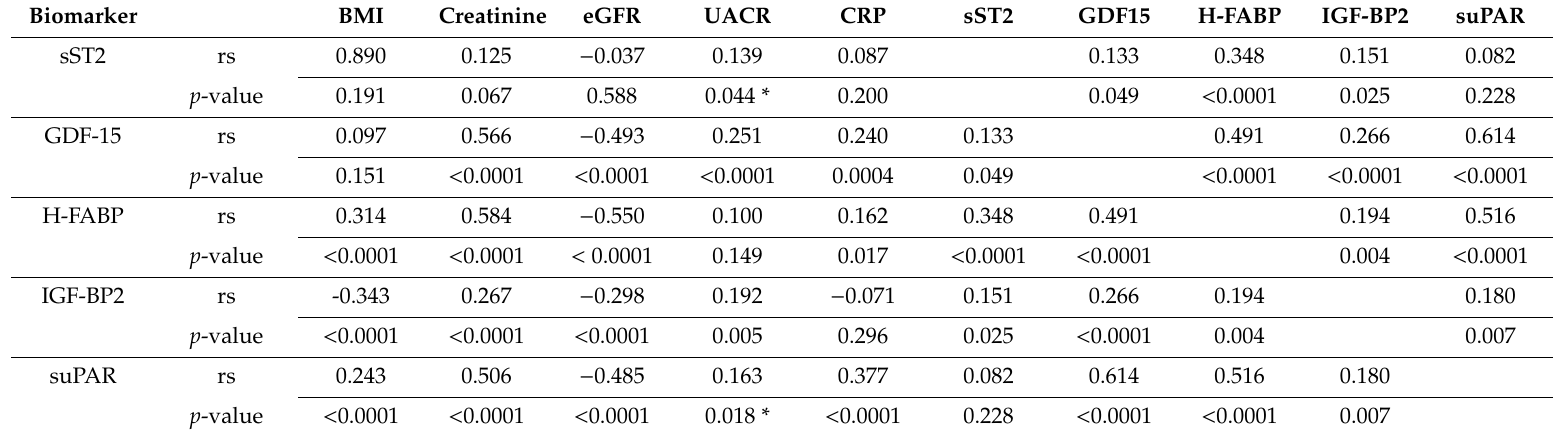
Table 2. Correlation analysis of the investigated